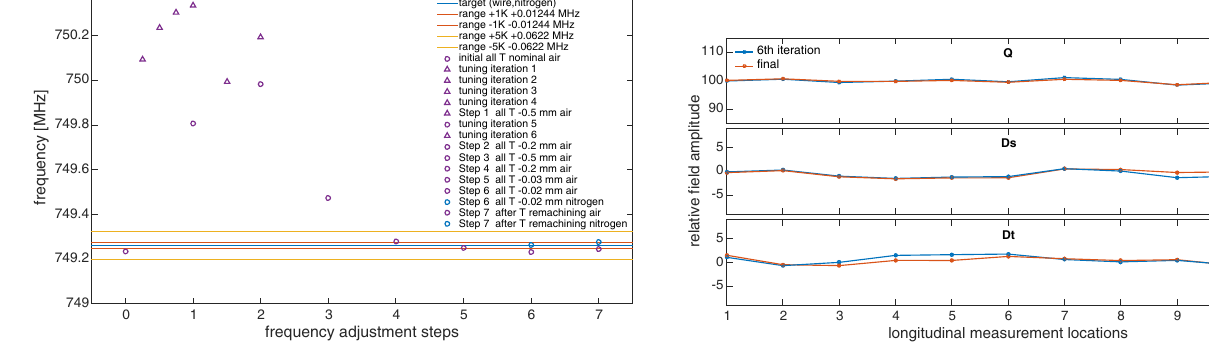
FIG. 17. The plot shows the field distribution of the Q, Ds, and Dt component for the last tuning iteration 6 and the final field distribution after frequency adjustment and final assembly of the tuners with copper